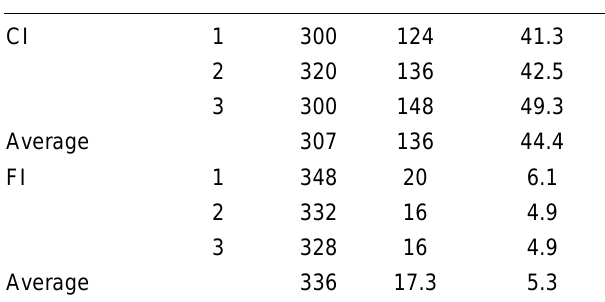
Total and Infected Rice Plants in the CI and FI Treatments Conducted at Dongyang Research